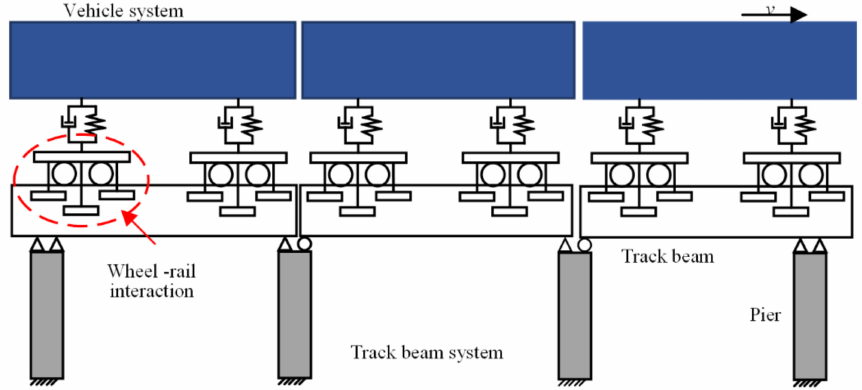
Figure 1. The dynamic model of the straddle-type monorail vehicle-track beam coupling